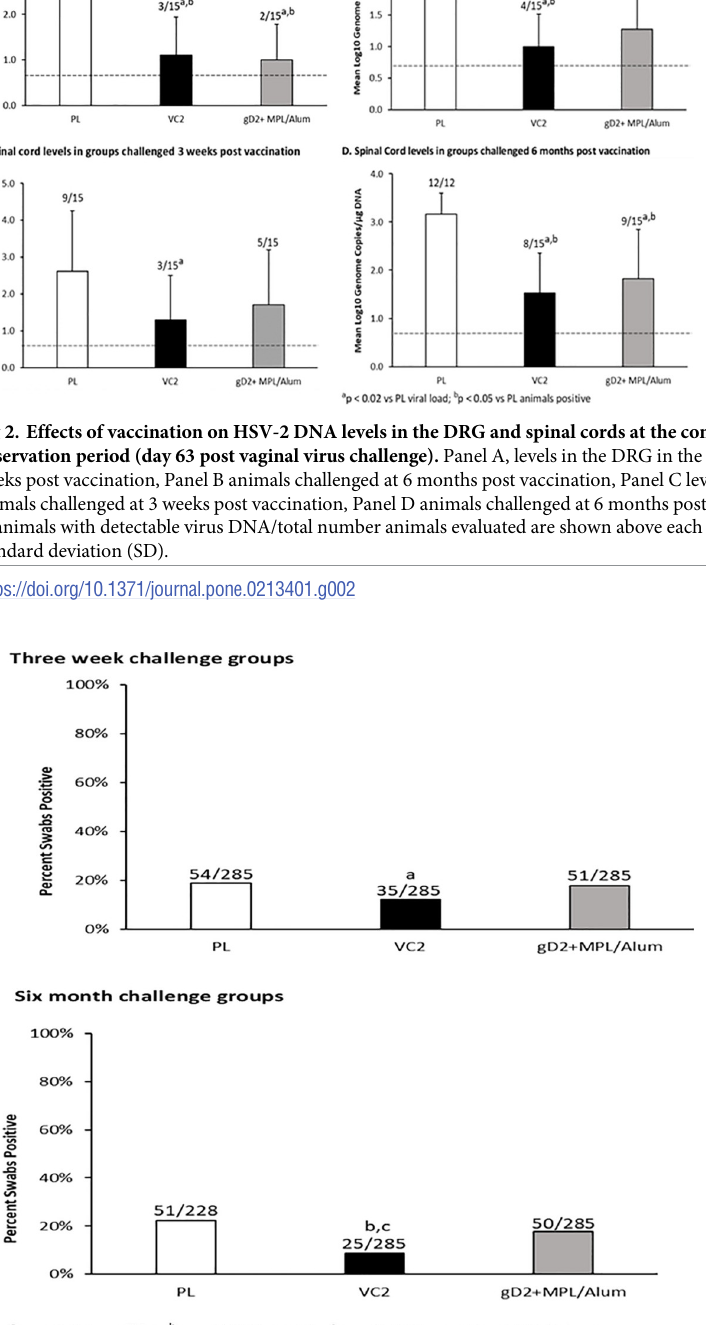
PLOS ONE | https://doi.org/10.1371/journal.pone.0213401 March 27,